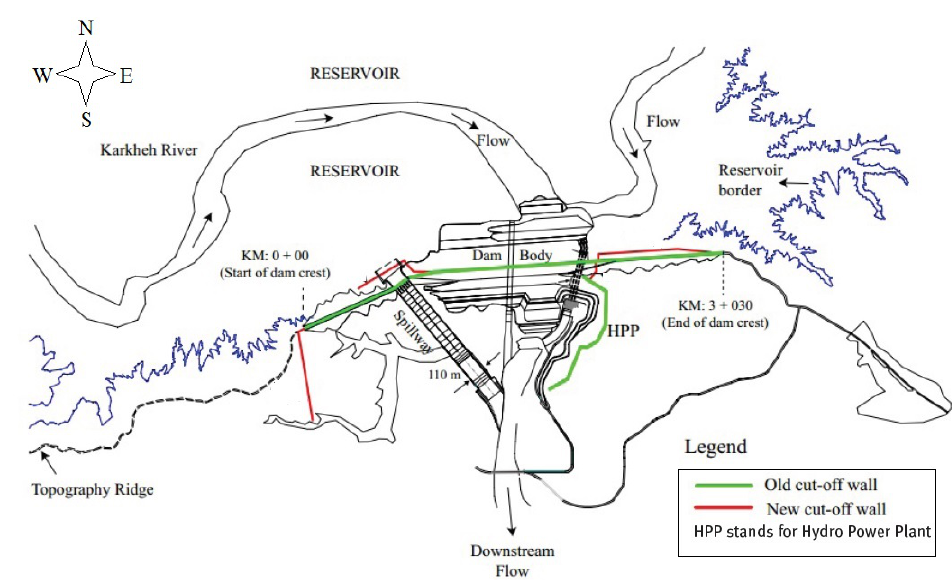
Figure 1. Plan of the Karkheh dam (Andimeshk, Iran), showing old and complementary cutoff wall. A spillway radial gate is composed of a skin plate connected by trusses to a trunnion or pinned joint that can be rotated about the trunnion to adjust the water flow through hydraulic structures (link rod) as shown in Figure 2a radial (or Taintor) gate acts similarly to a section of a drum. The pressure is transferred from the curved face through the horizontal support beams to the radial arms at the sides of the opening. The arms act as columns and transfer thrust to a common bearing located on either side of the gate opening. Flow is underneath the curved face as the gate is opened. This design results in a lightweight, economical gate that can be opened and closed with minimum effort and with a comparatively small number of turns of the handwheel on the hoist.